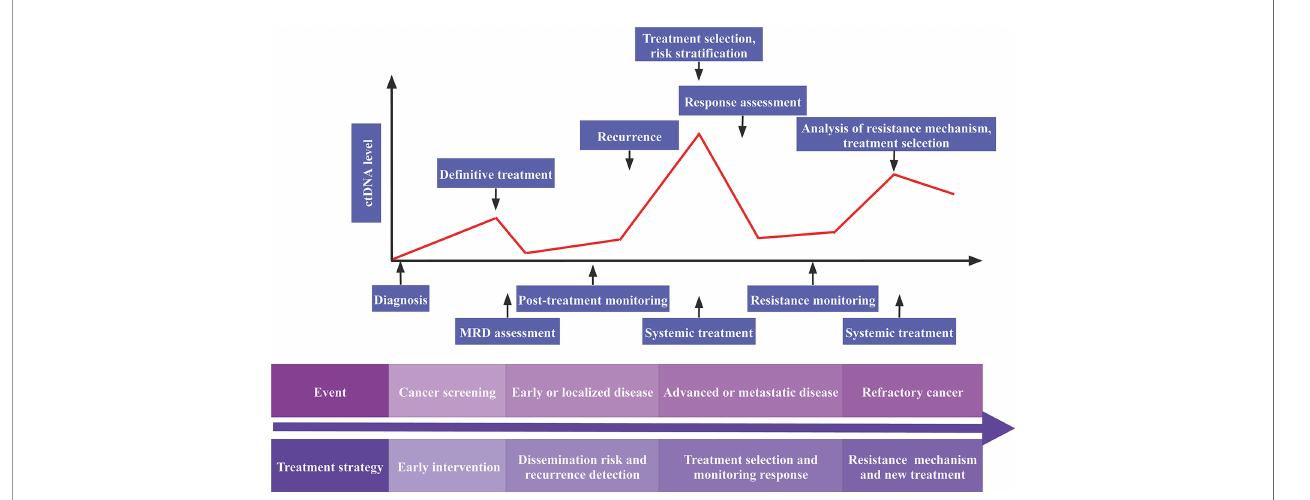
FIGURE 2 | Potential clinical applications of ctDNA analysis. MRD, minimal residual disease; ctDNA, circulating tumor